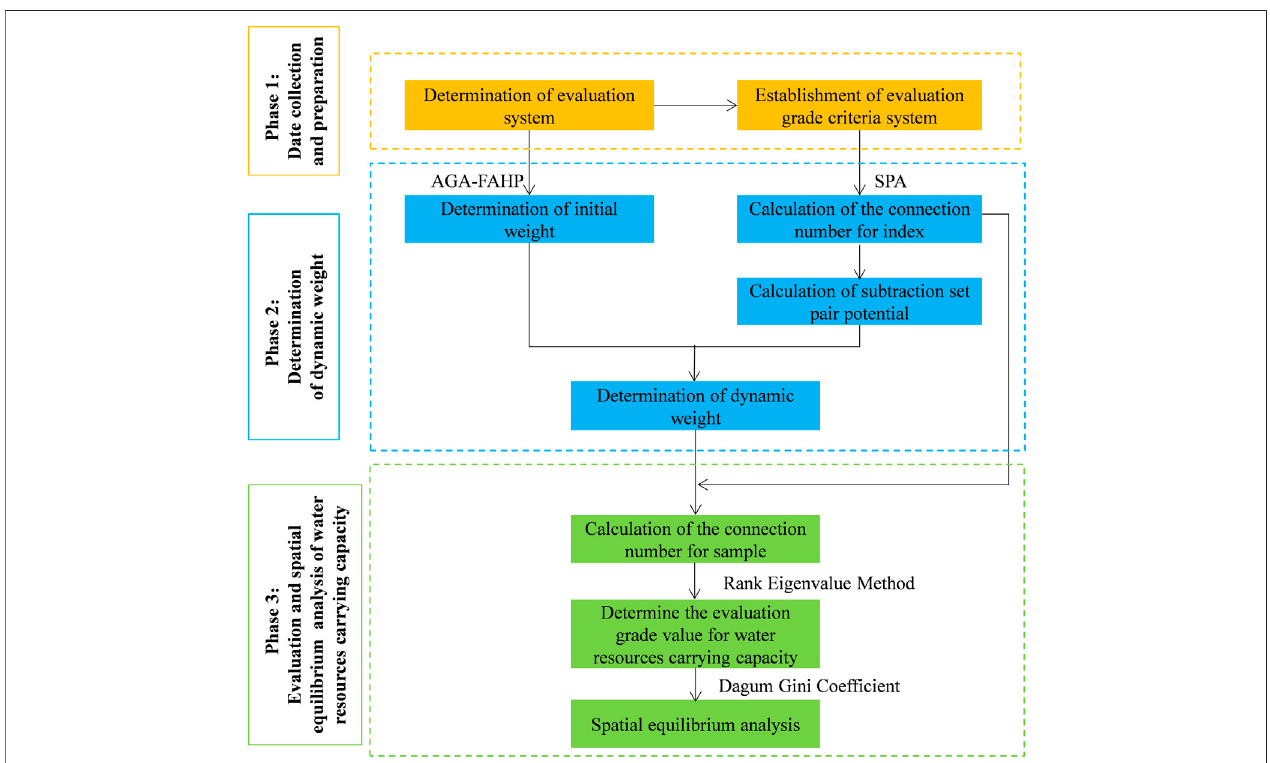
FIGURE 1 | Research